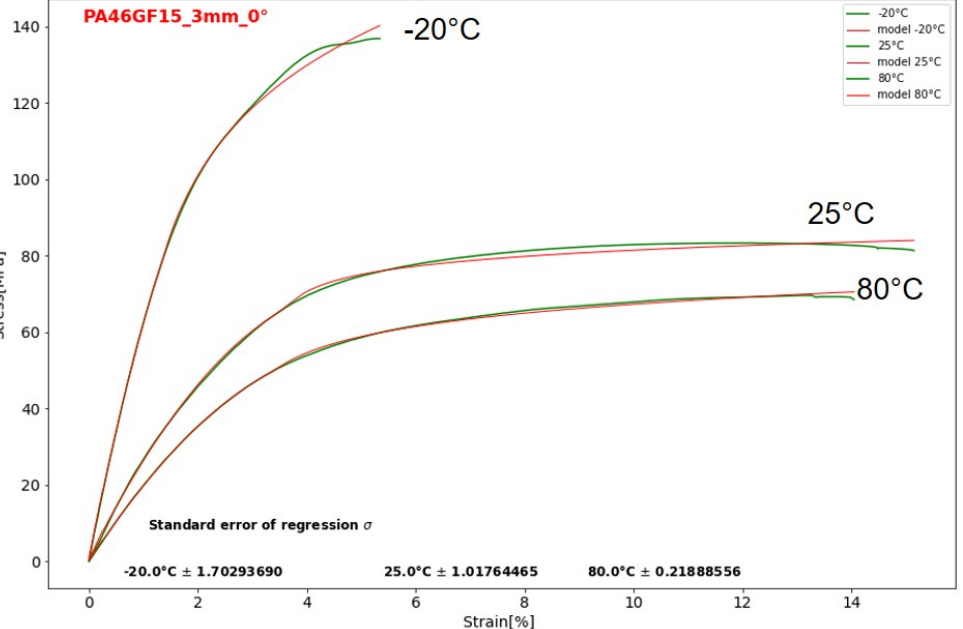
Figure 6. 1P stress–strain model with strain as an independent variable 𝜎 = 𝑓(𝜖) . Green lines are experimental data and red lines are model data (1P model). The room temperature test is considered as 25 °C.